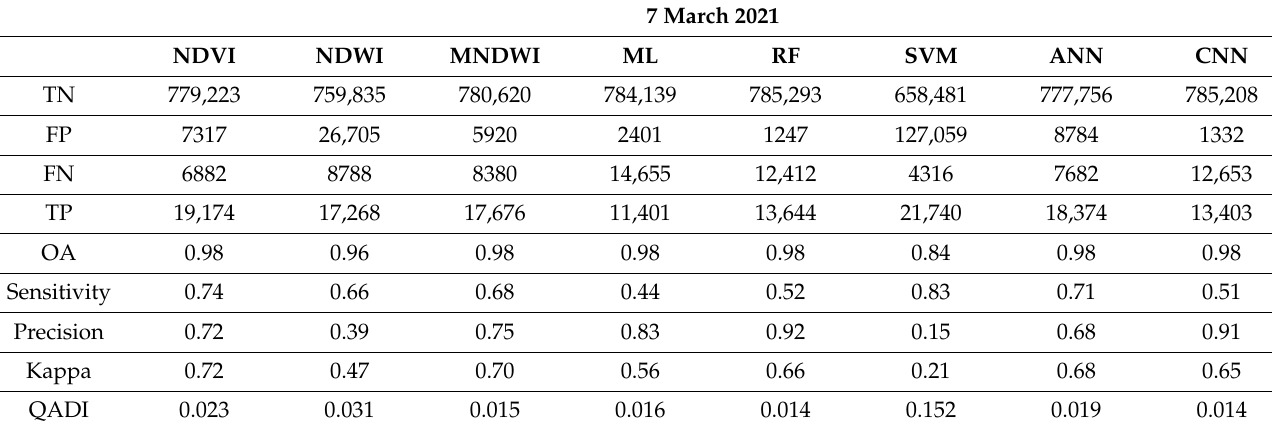
Table 2. Statistical comparison of methods for the second